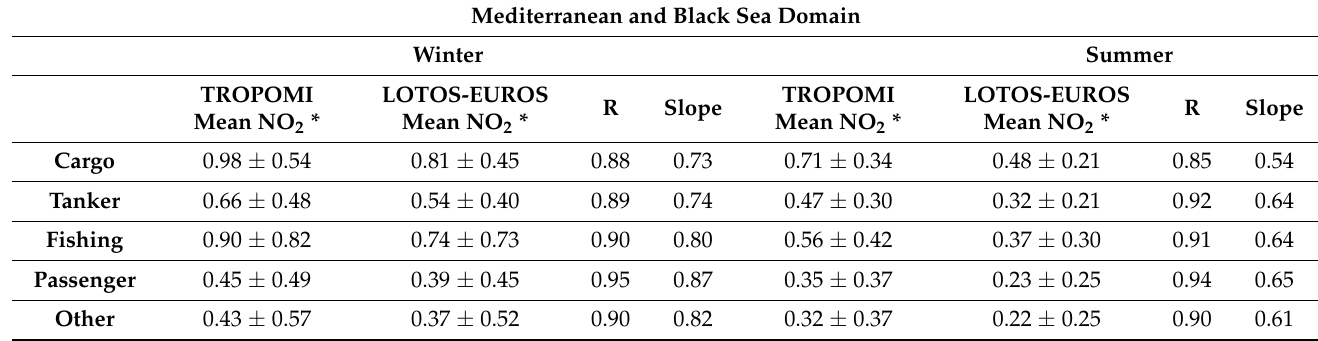
Figure 10. Seasonal comparison between the tropospheric NO 2 loads reported by TROPOMI and LOTOS-EUROS over the Mediterranean and Black Sea domain per vessel type: ( a ) Winter; ( b ) Summer. Table 3. Seasonal statistics for the shipping activities sensed by TROPOMI and simulated by